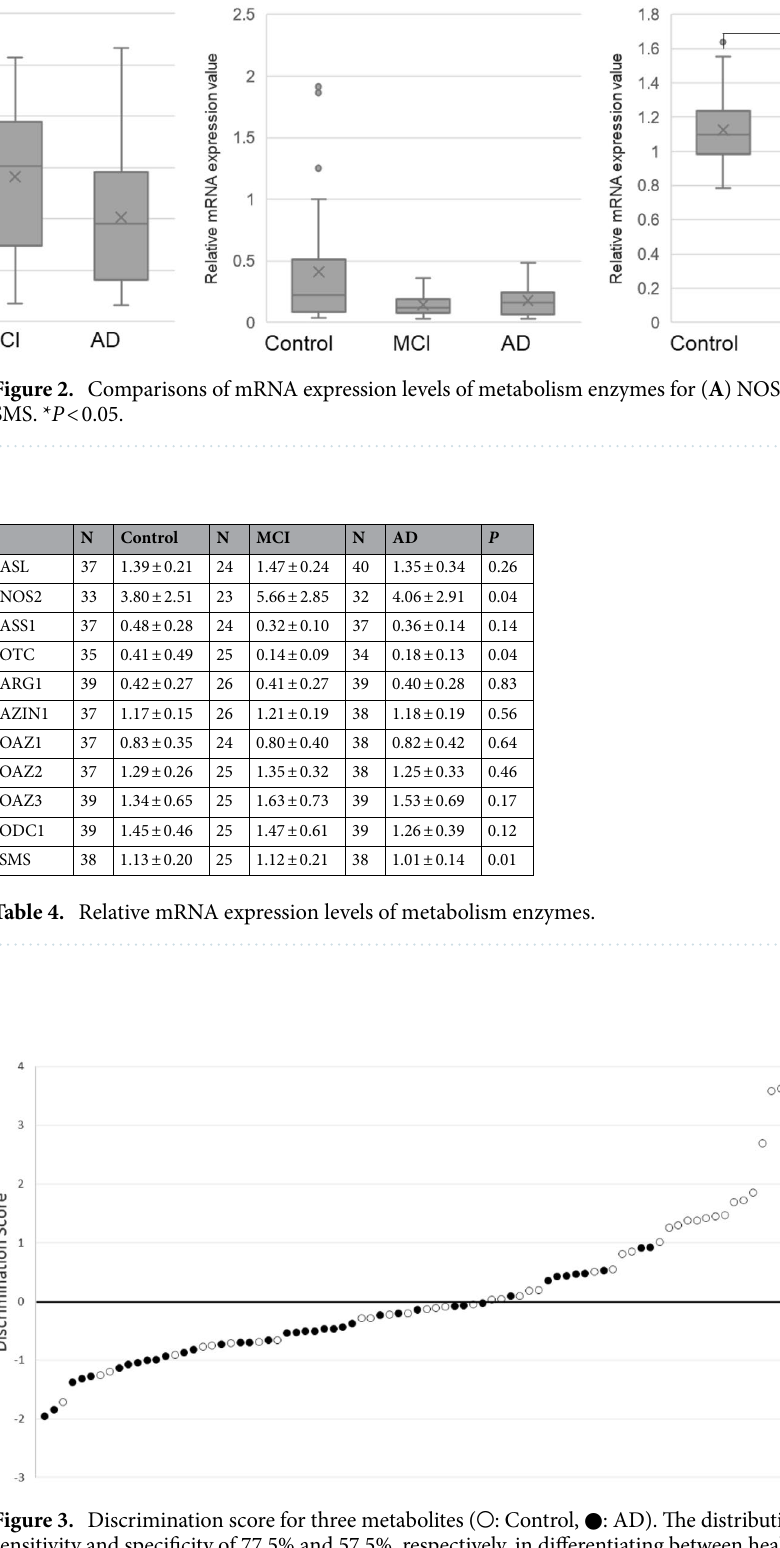
Figure 3. Discrimination score for three metabolites ( ○ : Control, ● : AD). The distribution of scores, with sensitivity and specificity of 77.5% and 57.5%, respectively, in differentiating between healthy controls and AD